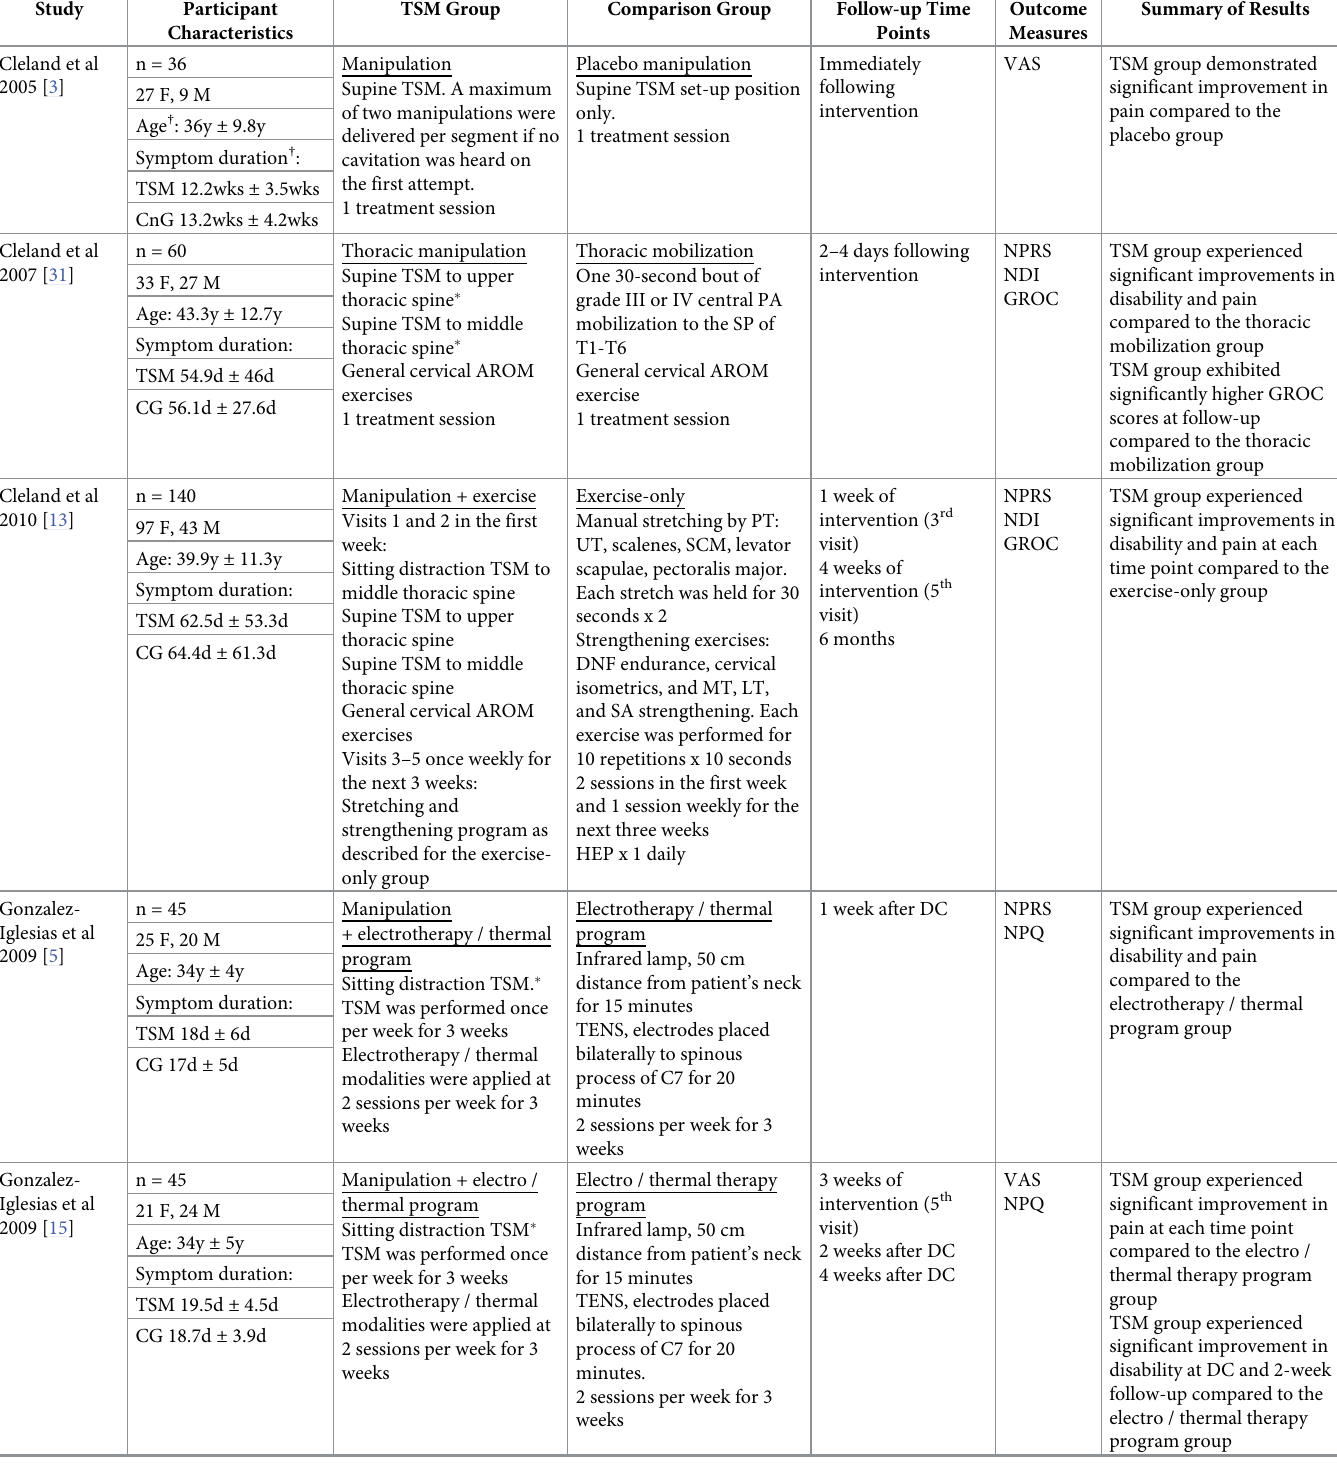
Table 3. Description of